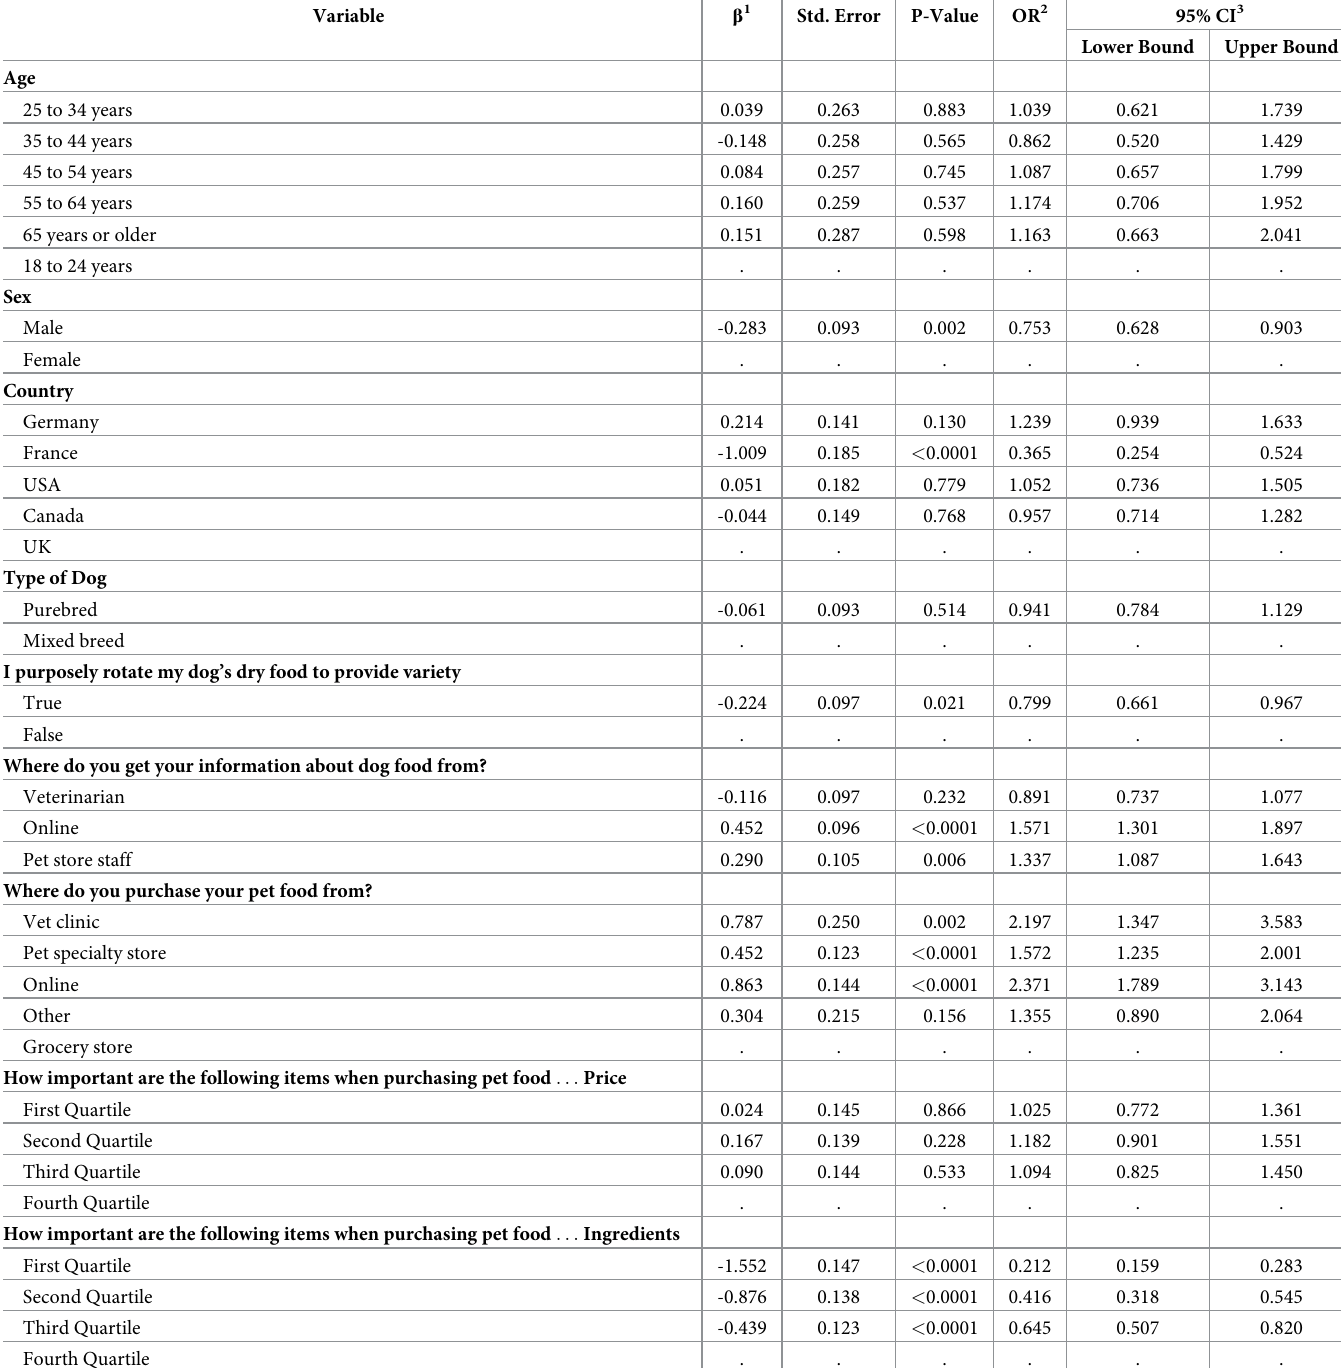
Table 5. Multinomial logistic regression parameter estimates for the Purchasing Habits